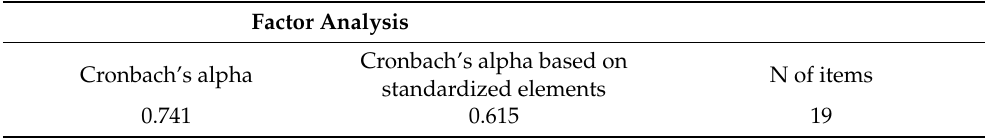
Table 6. Cronbach’s alpha calculation of the third dimension. Factor Analysis